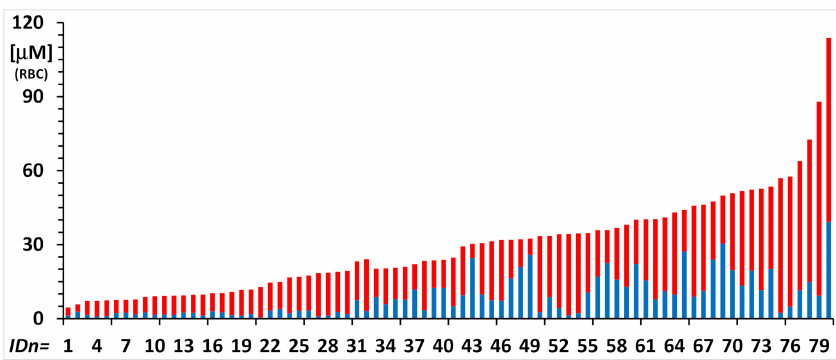
Figure 7. Nitrite (blue bar) and nitrate (red bar) concentrations were measured in 80 RBC samples from anonymized subjects who participated in two studies under the extreme conditions of breath-hold diving (8 subjects; n = 32 samples) and of dwelling for six months in the Concordia Antarctica station (9 subjects; n = 48 samples).